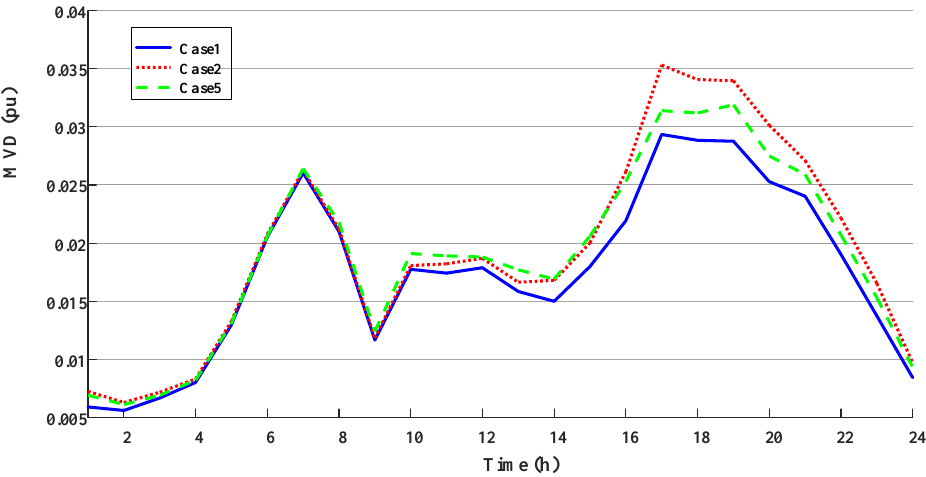
Figure 8. Maximal voltage deviation of the distribution network.